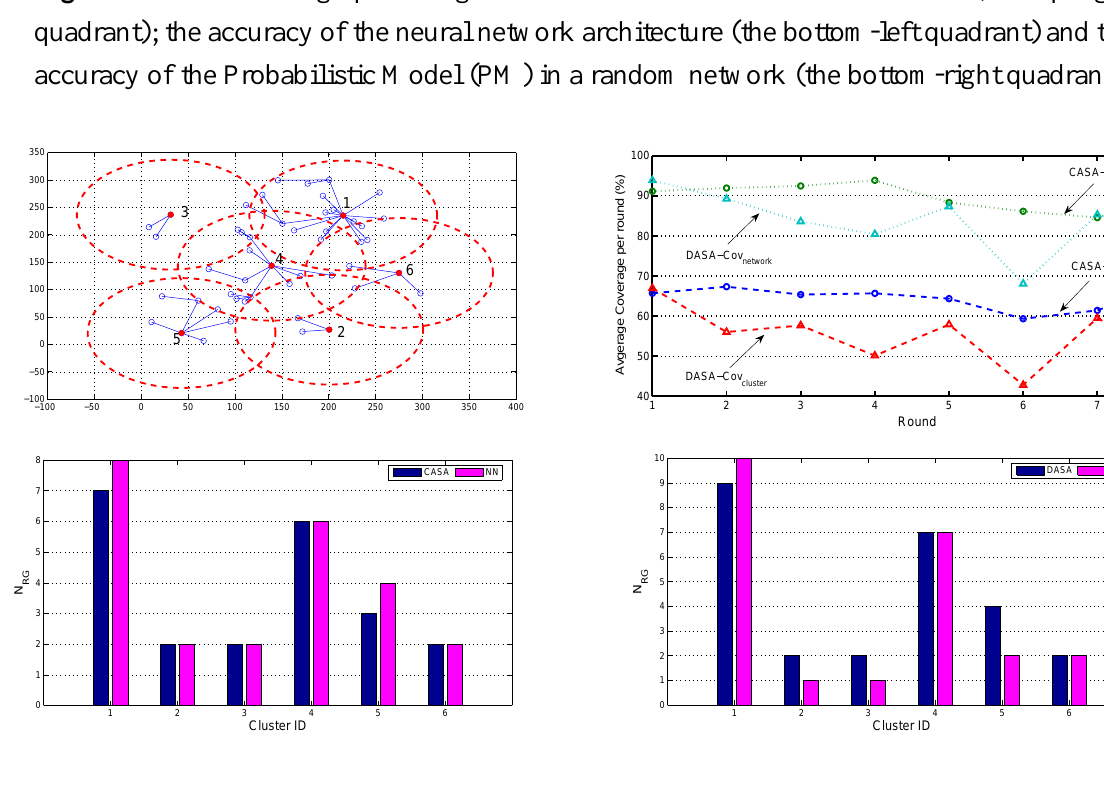
Figure 19. The distribution of the number of sensing rounds N scheduling schemes and those using the analytical models with N